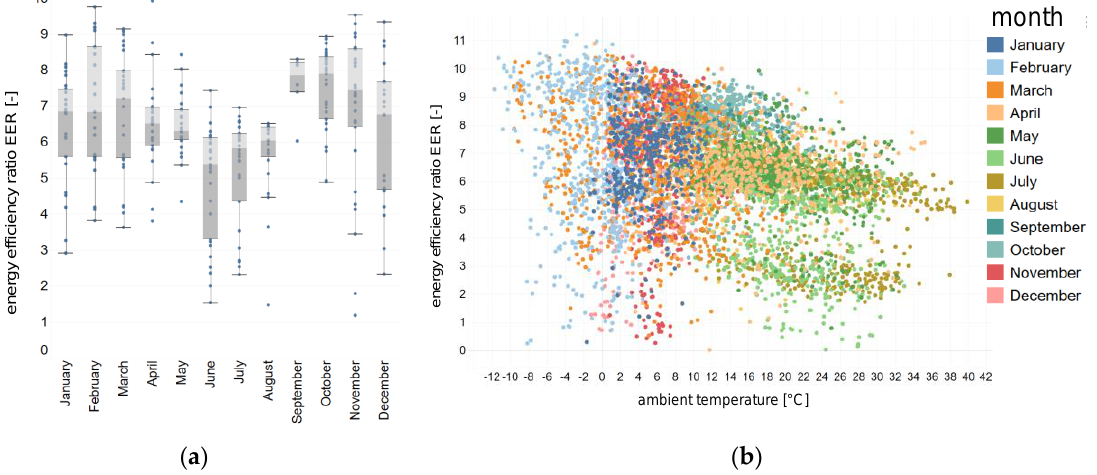
Figure 7. ( a ) Boxplot of energy e ffi ciency ratio (EER) for cooling tower (CT) system over the year (based on daily data); ( b ) EER in relation to ambient temperature (based on hourly data, coloring indicates related operation